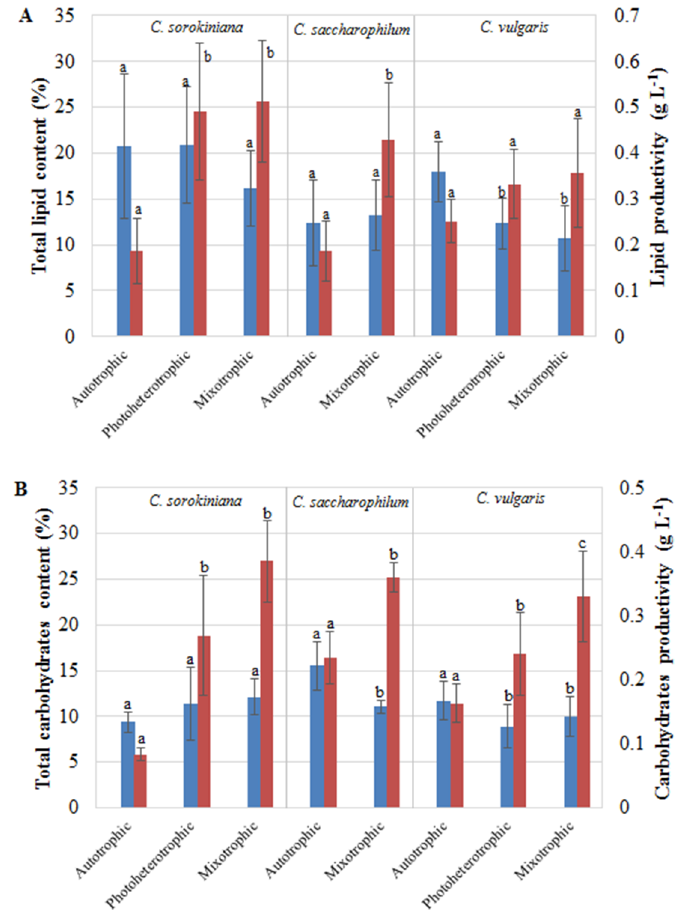
Figure 2. Influence of trophic modes on lipids ( A ) and carbohydrates ( B ) of C. sorokiniana , C. saccharophilum , and C. vulgaris. The blue columns represent the total lipid and the carbohydrate contents, and the red columns represent productivities. (the results are presented as a mean of measurements ± SD; the same letter means no significant differences; Tukey’s honestly significant difference test at p < 0.05).